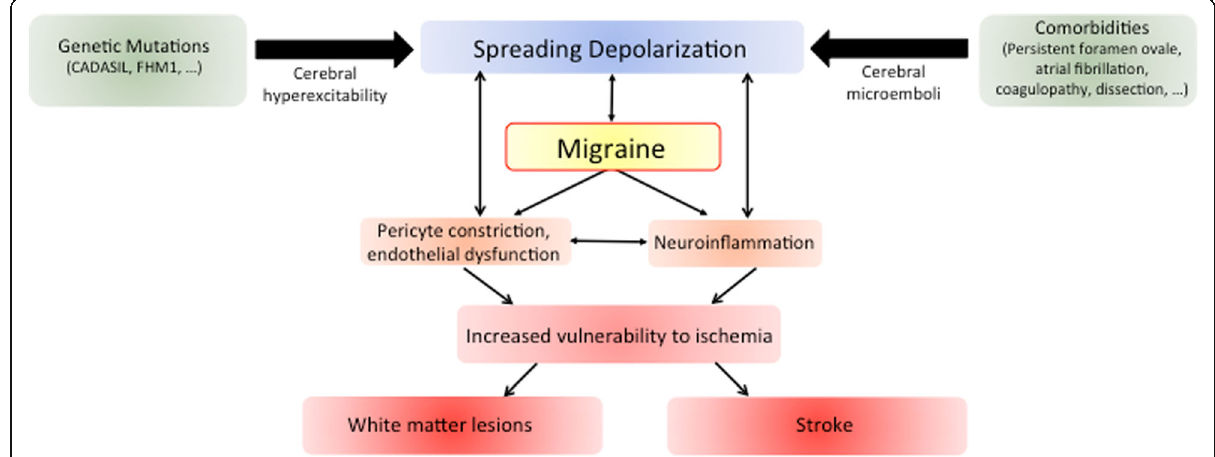
Fig. 1 The interplay between migraine and stroke. Shared genetic factors and associated clinical features commonly observed in migraine patients contribute to the link between migraine and stroke. The underlying mechanism involves facilitation of spreading depolarization (SD), the electrophysiological correlate of aura, via increased SD trigger factors and/or reduced threshold for SD induction. SD then causes migraine as well as neuroinflammation and vascular dysfunction, increasing the brain ’ s vulnerability to ischemia. This cascade may result in clinically silent ischemic lesions that are frequently observed in migraineurs, or even cause ischemic